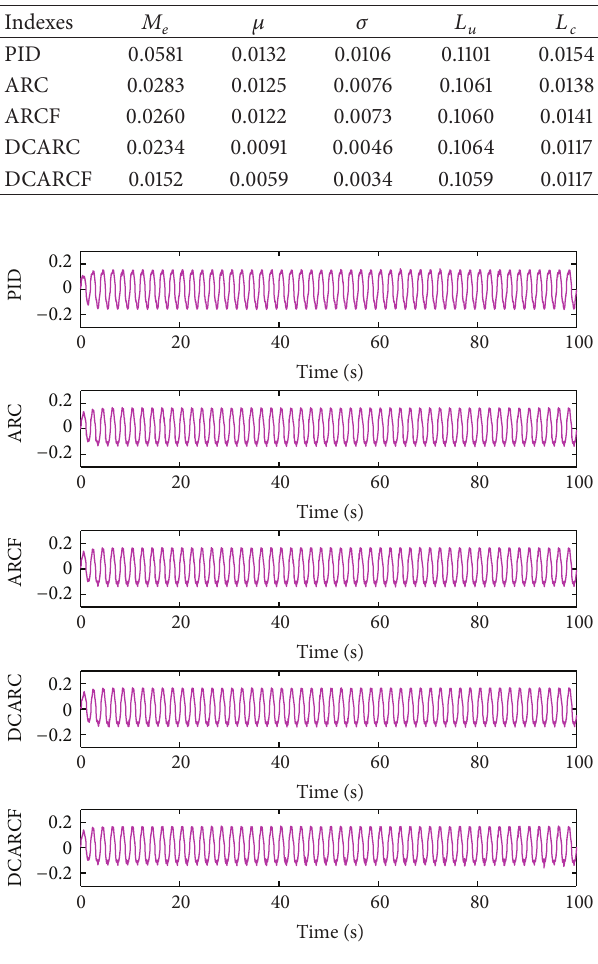
Figure 7: Control inputs of five controllers in normal case (the ordi- nate unit is V).